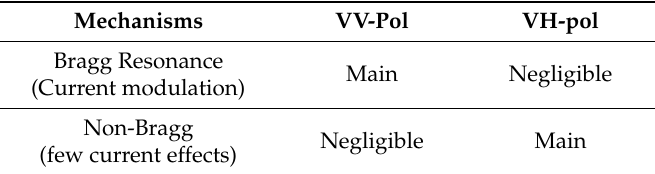
Table 1. The roles of the two mechanisms with respect to the two polarizations (VV & VH). Mechanisms Bragg Resonance (Current modulation)